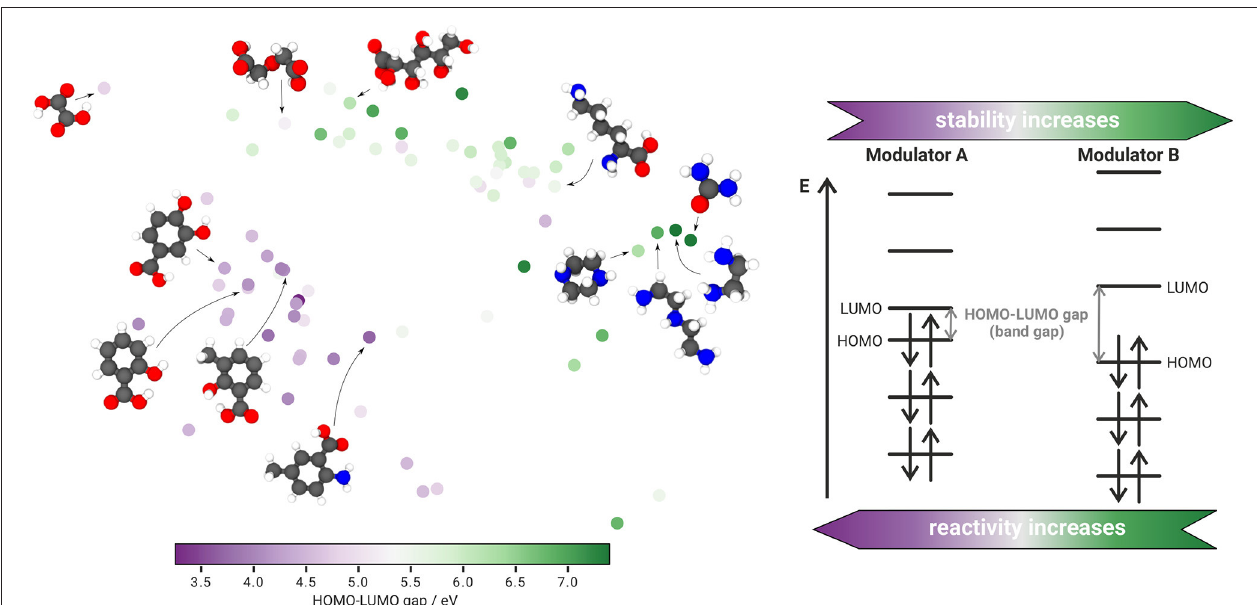
FIGURE 3 | Property-structure landscape based on the SOAP-REMatch kernel and sketch-map. The structural data points are colored according to their corresponding HOMO-LUMO gap, as presented schematically. The color code clearly highlights the separation of aromatic compounds with low and aliphatic compounds with high HOMO-LUMO